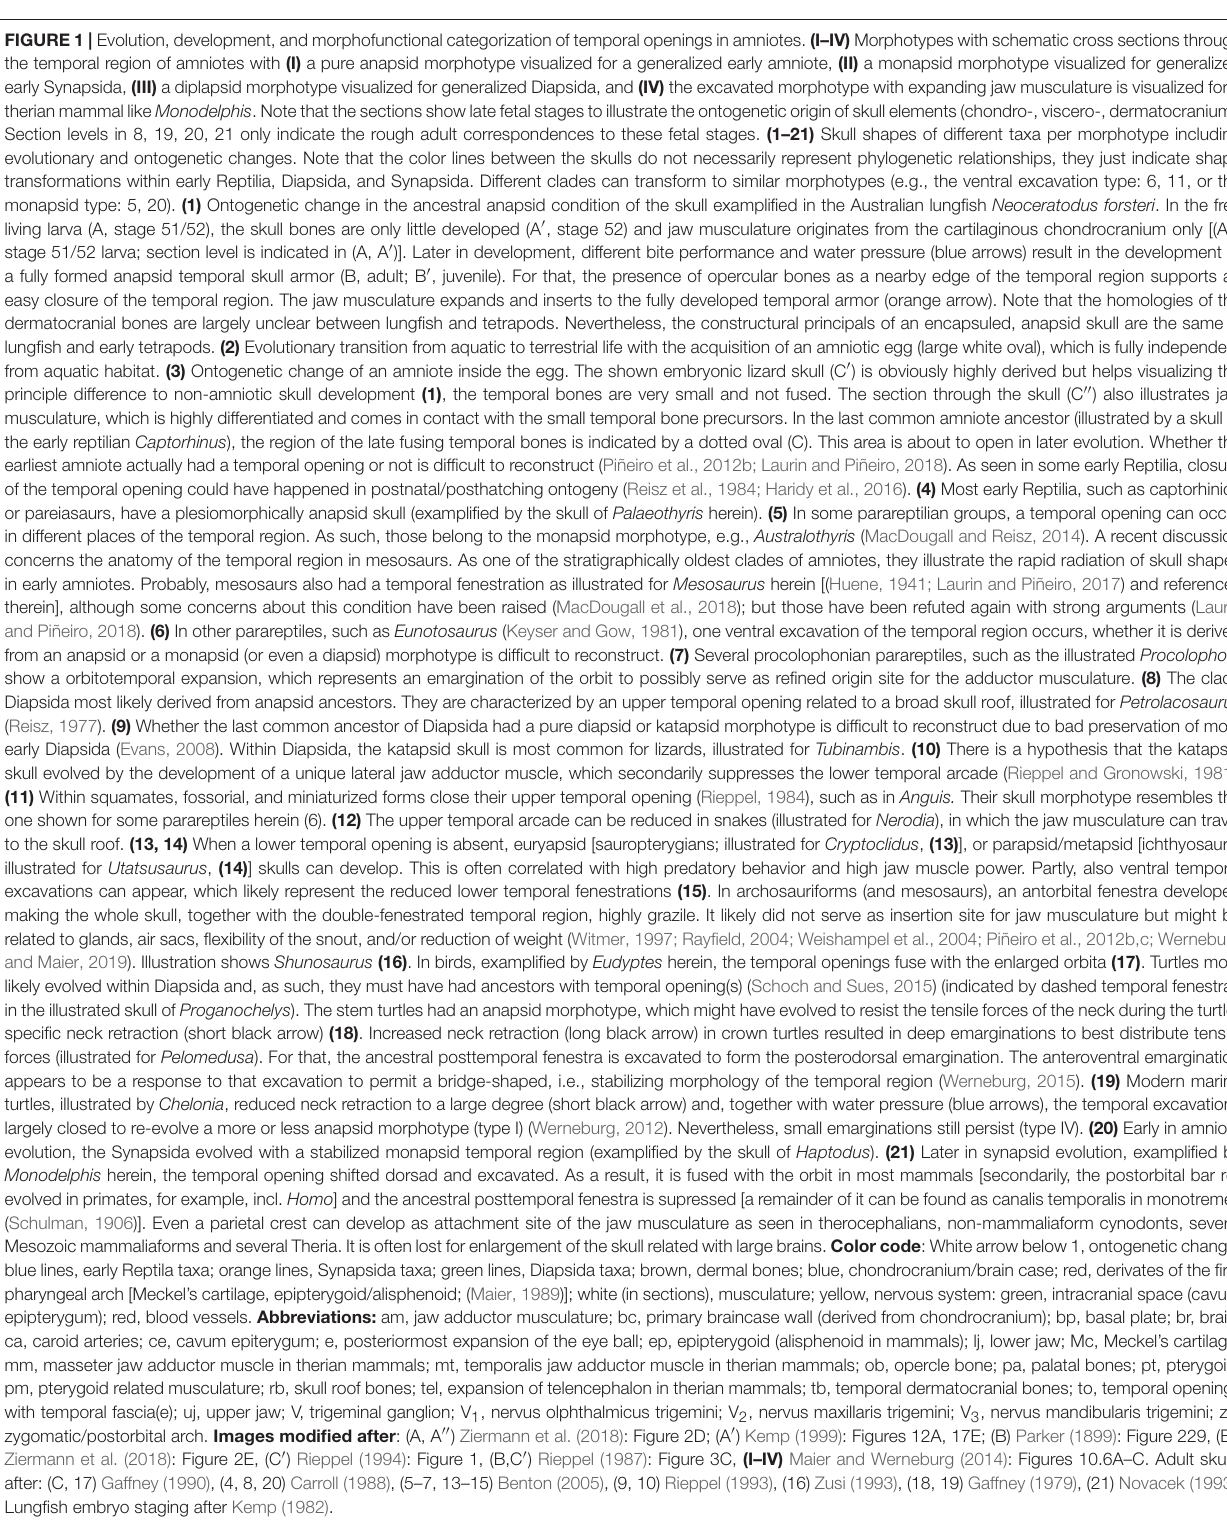
FIGURE 1 | Evolution, development, and morphofunctional categorization of temporal openings in amniotes. (I–IV) Morphotypes with schematic cross sections through the temporal region of amniotes with (I) a pure anapsid morphotype visualized for a generalized early amniote, (II) a monapsid morphotype visualized for generalized early Synapsida, (III) a diplapsid morphotype visualized for generalized Diapsida, and (IV) the excavated morphotype with expanding jaw musculature is visualized for a therianmammallike Monodelphis